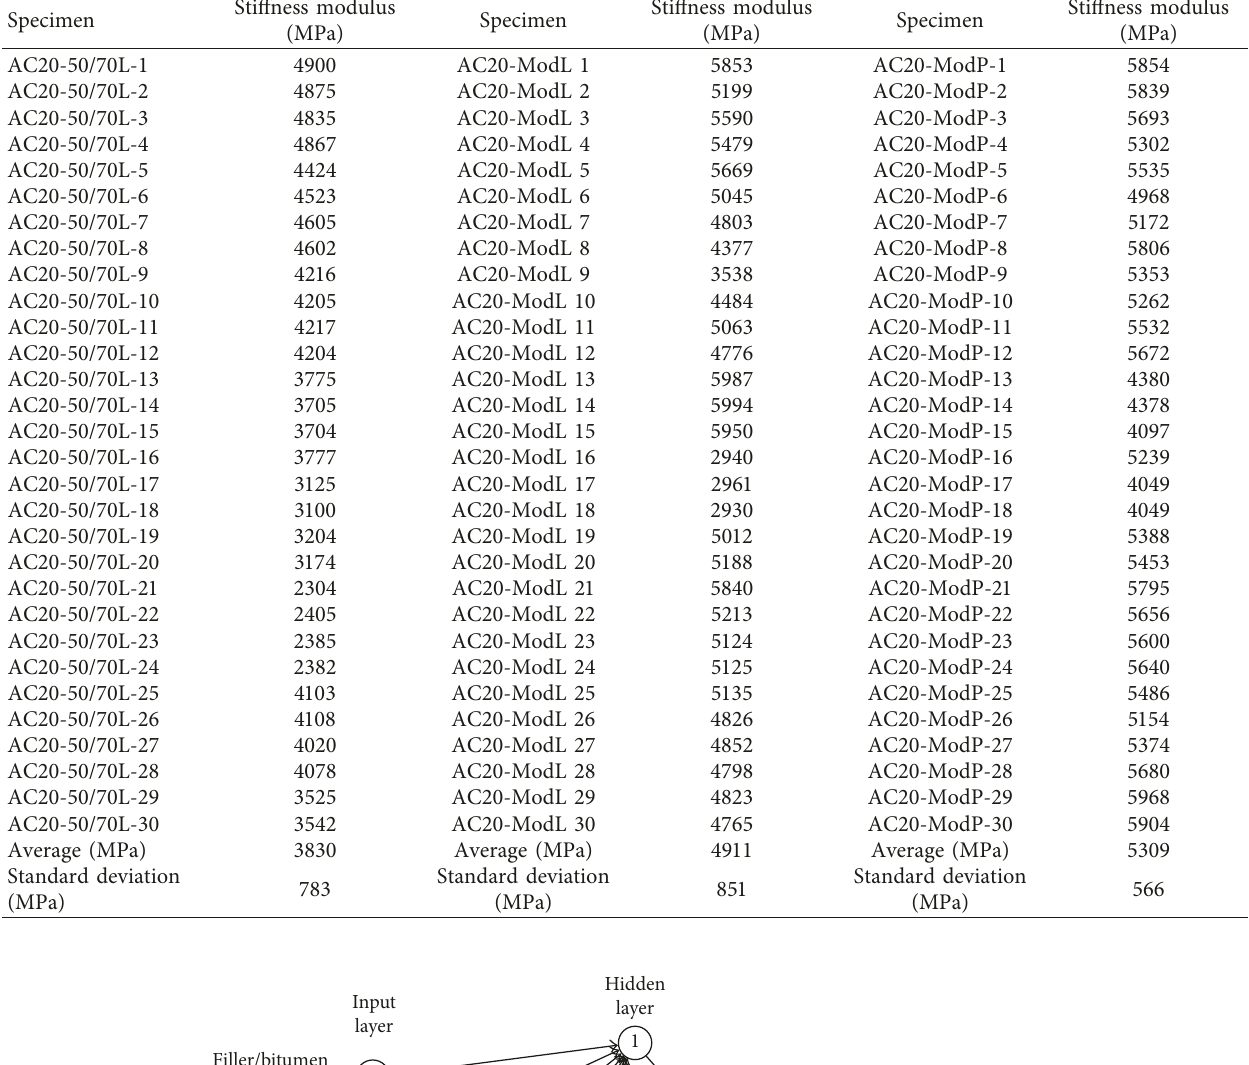
Table 6: Stiffness tests results.